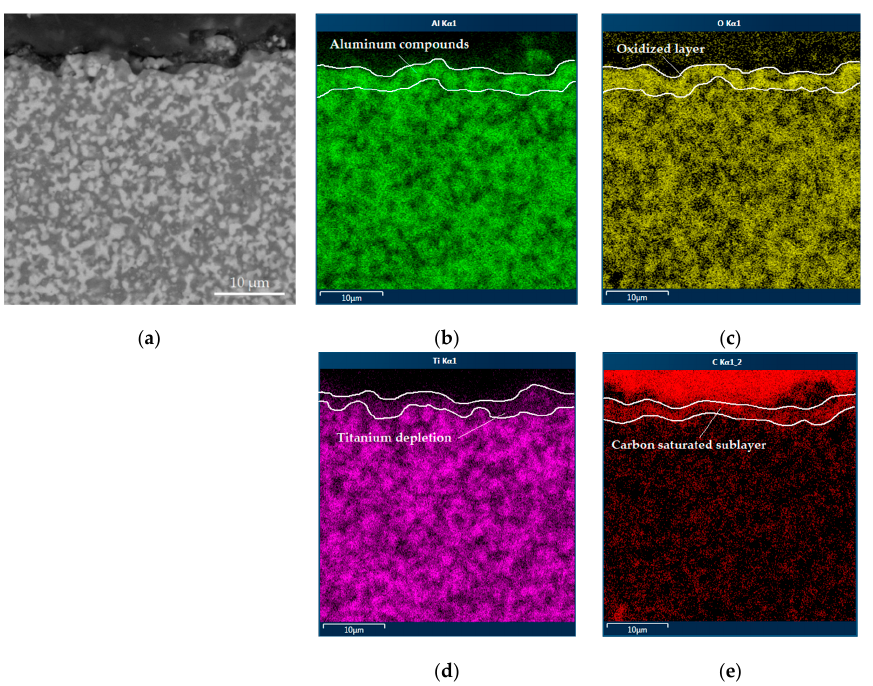
Figure 9. Microstructure and elemental mapping of the Al 2 O 3 + 30%TiC nanocomposite machined in oil medium: ( a ) Microstructure in back-scattered electrons (BSE), 5.0 k×; ( b ) Aluminum; ( c ) Oxygen; ( d ) Titanium; ( e ) Carbon.